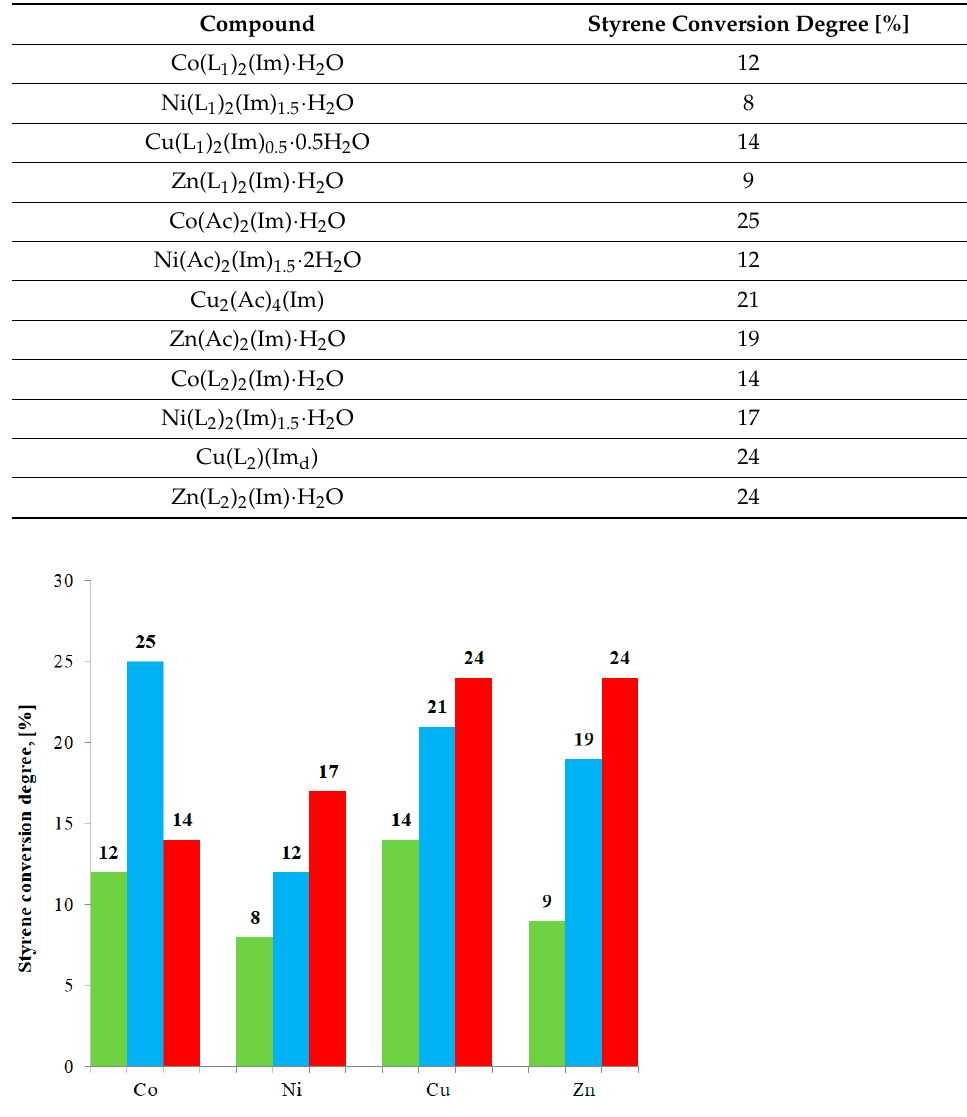
Figure 8. Styrene conversion degree for investigated compounds. Green bars: M(II) formate-imidazole complexes; blue bars: Previously studied M(II) acetate-imidazole complexes [25]; and red bars: M(II) propionate-imidazole complexes.